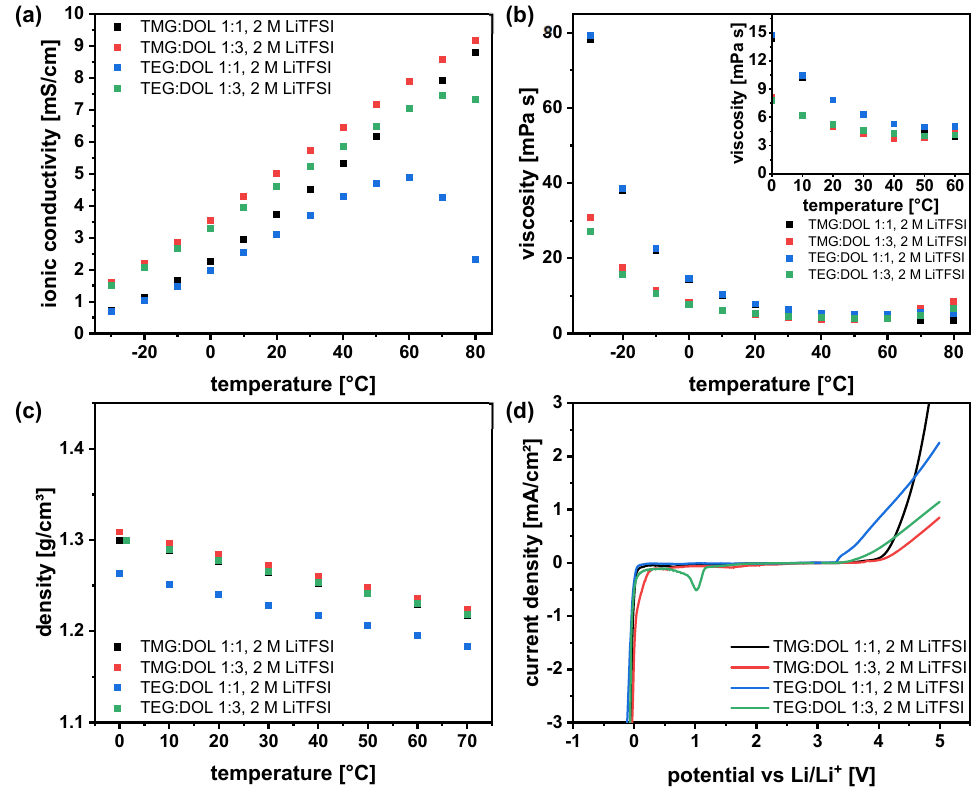
Figure 5. Determination of electrolyte properties: ( a ) Ionic conductivities determined with a cell, con- sisting of two parallel platinized Pt-electrodes, ( b ) viscosities determined with a rotational viscometer, ( c ) densities determined with an oscillating U-tube densitometer at varying temperatures, ( d ) electro- chemical stability tests performed in a three electrode cell using a Pt-disk as working electrode, an oversized activated carbon electrode as counter electrode and a Ag-wire as reference